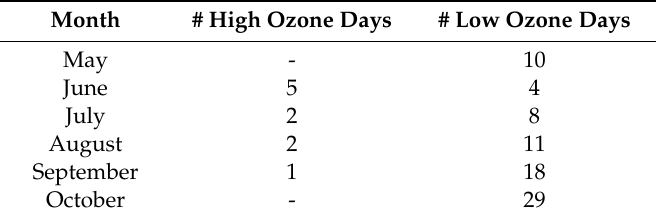
Table 3. Observed at CAMS 12, the high and low ozone episodes (as defined in Section 3.1) for the year 2017.